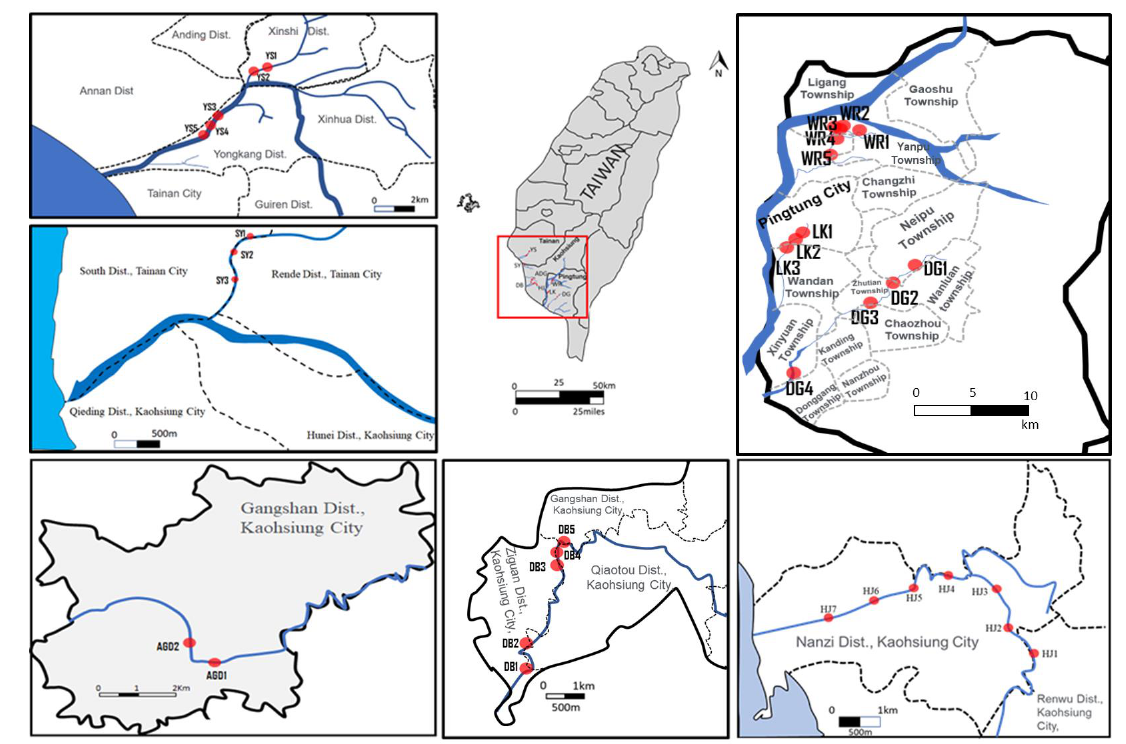
Figure 1. Sampling sites of riverine sediments in southern